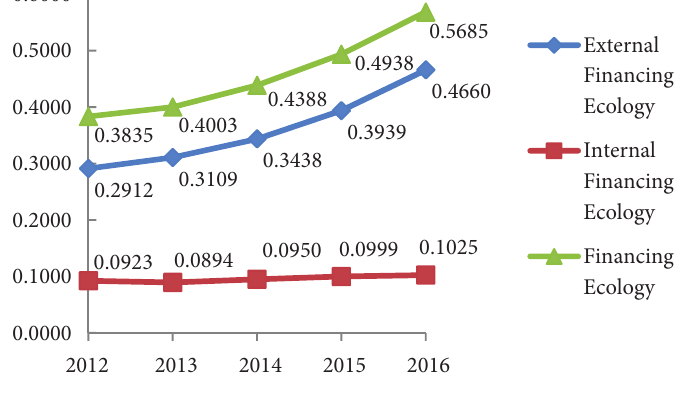
Figure 1. Financing ecology during